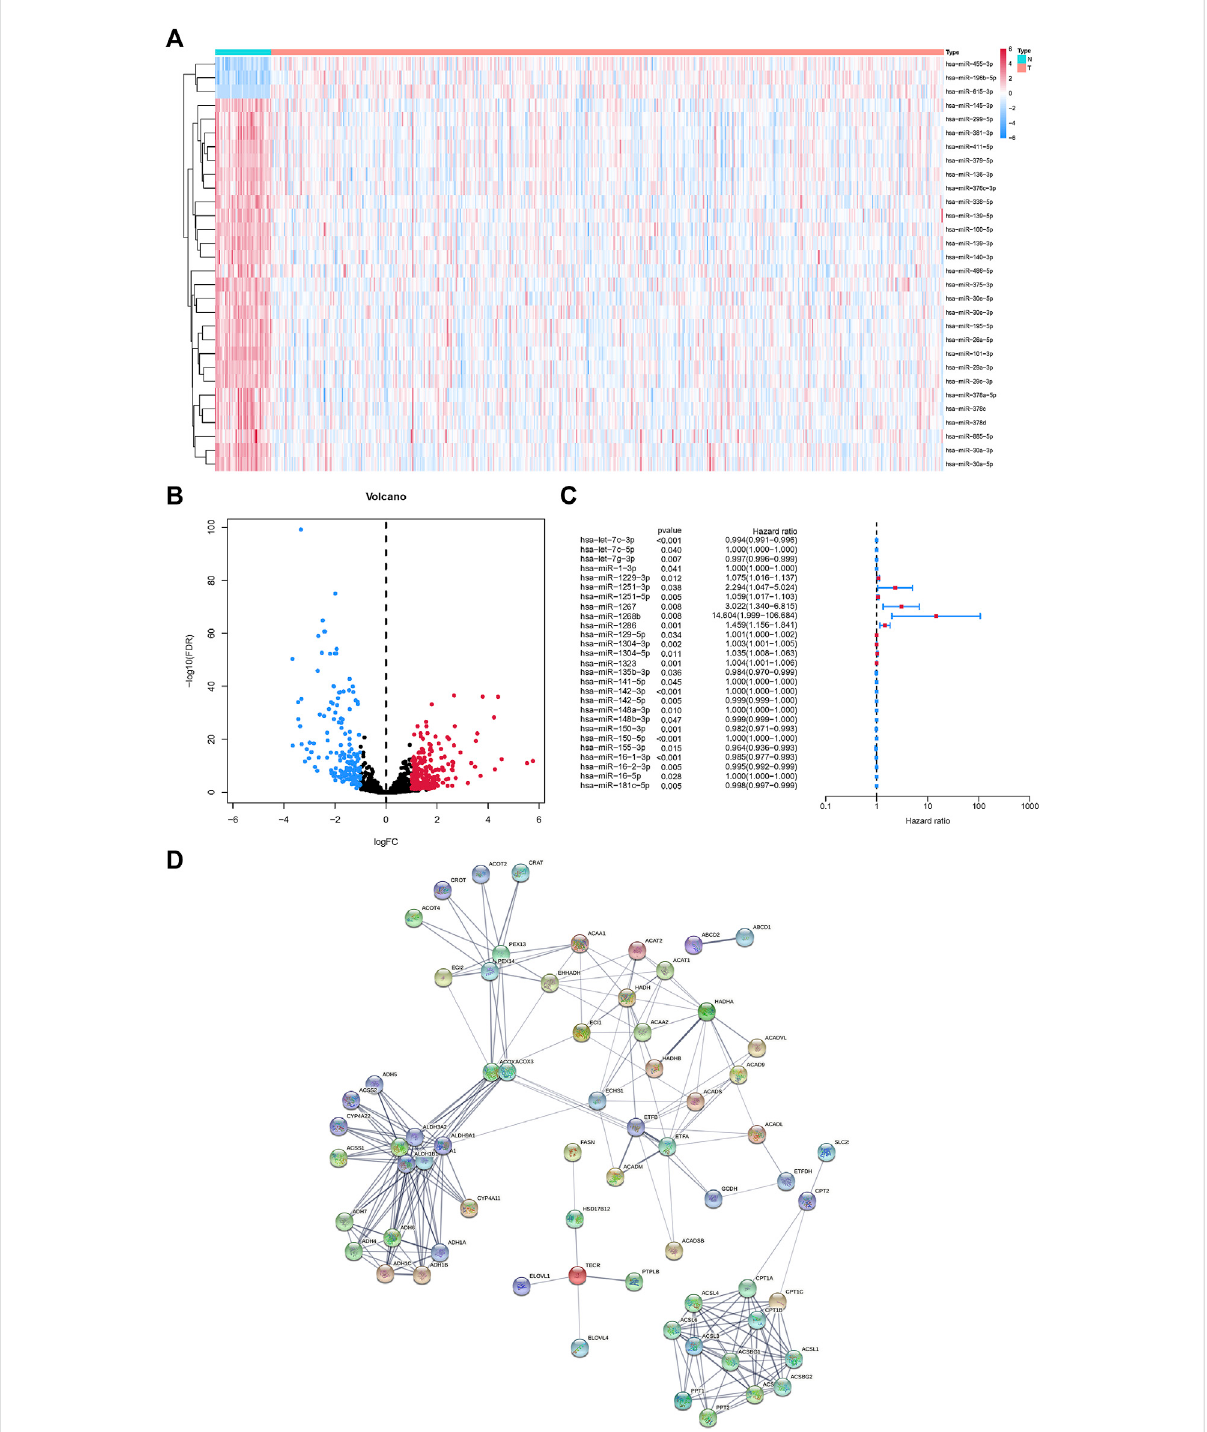
FIGURE 1 MicroRNAs associated with fatty acid metabolism in the HNSCC and matched normal tissues. (A) Heatmap of fatty acid metabolism-related microRNAs. (B) Volcano map of fatty acid metabolism-related microRNAs. (C) Univariate Cox regression analysis of fatty acid metabolism-related microRNAs. (D) Fatty acid metabolism-related microRNAs interactions revealed by